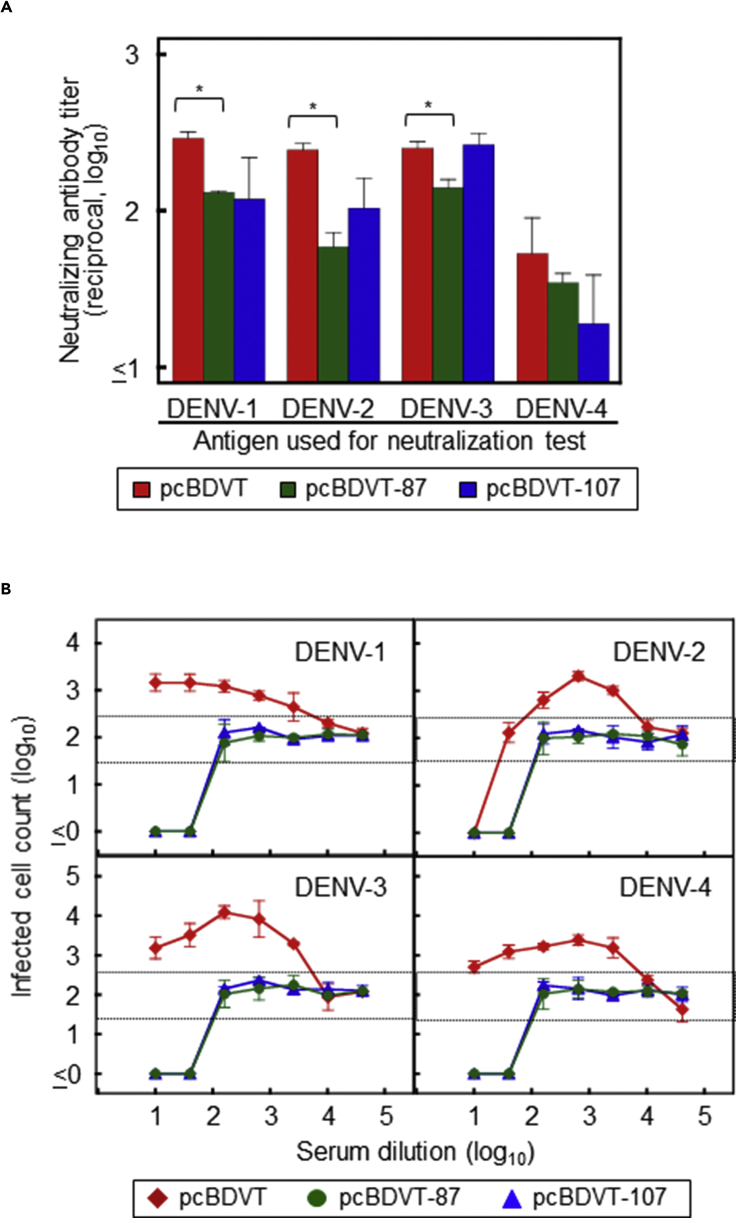
Assessment of EAb Induction Using a Tetravalent Vaccine(A and B) NAb titers (A) and enhancing activities (B) induced in mice immunized with a tetravalent formulation of pcBDV1–4 (pcBDVT) or their variants designed to express E containing amino acid substitutions of D87N (pcBDVT-87) or L107F (pcBDVT-107). (A) PRNT75 antibody titers were obtained from two independent experiments. The x axis shows the serum dilutions corresponding to the PRNT75 value. Asterisks indicate significant differences (p< 0.05) from the PRNT75 values obtained for pcBDVT. (B) Enhancing activities were obtained from two independent experiments. The x axis shows the serum dilution, and the y axis displays the infected cell counts (in log10). Labels in panels indicate serotypes of assay antigens. For dotted lines, see the legend of Figure 2. Data represent averages of two independent assays ± SD.See also Figure S4.